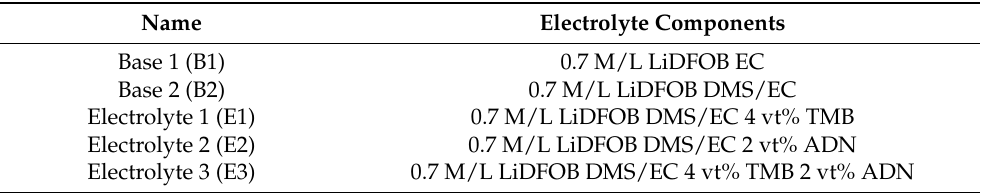
Table 1. The prepared electrolytes used in the